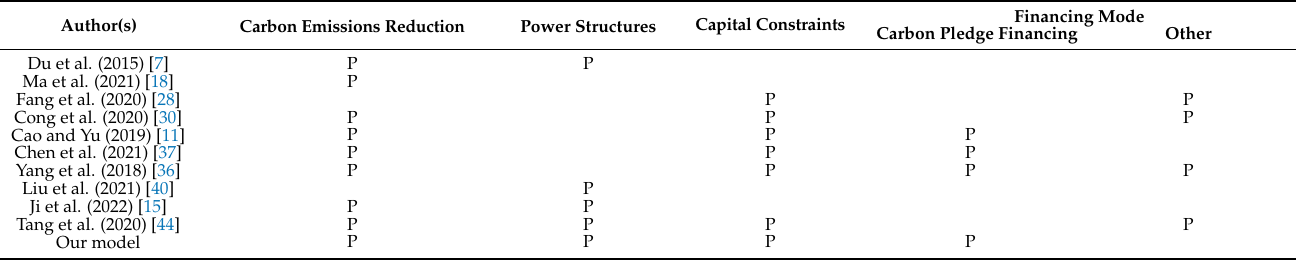
Table 1. The differences between our model and those from previous